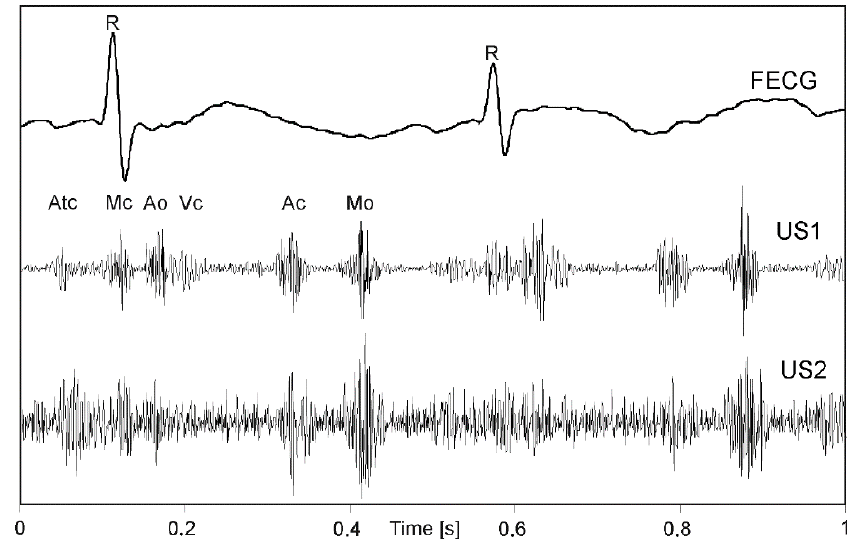
Figure 1. An example of the one-second direct electrocardiogram (FECG) with Doppler ultrasound signals from two transducers (US1, US2) attached to maternal abdomen in different position relative to a fetal heart. In the US signal the cardiac phases are observed: opening and closing the crescent—Ao and Ac, atrioventricular valve—Mo and Mc, atrial wall contraction—Atc and walls heart chambers—Vc.